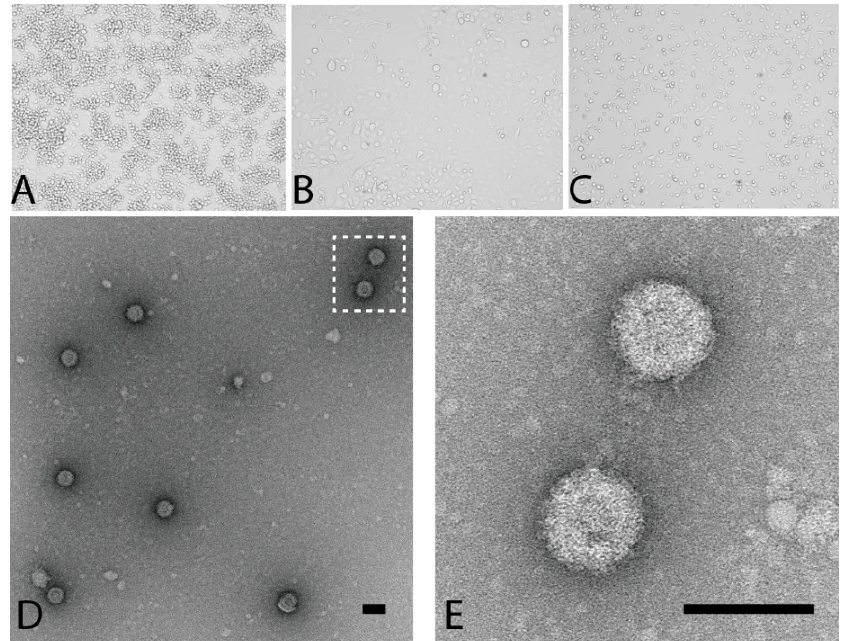
Figure 1. Parry’s Lagoon virus (PLV) Morphology and Growth Characteristics. PLV induces distinct CPE on C6/36 monolayers at 5 days post infection. ( A ) mock-infected C6/36 cells; ( B ) PLV-infected C6/36 cells and ( C ) Corriparta virus (CORV)-infected C6/36 cells; ( D , E ) Culture supernatant of C6/36 cells infected with PLV was concentrated and virions negatively stained using a 1% uranyl acetate solution. Scale bar represents 80 nm.